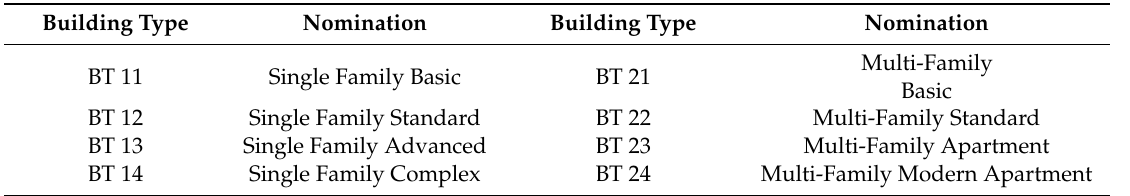
Table 2. Building types with respective nomination.